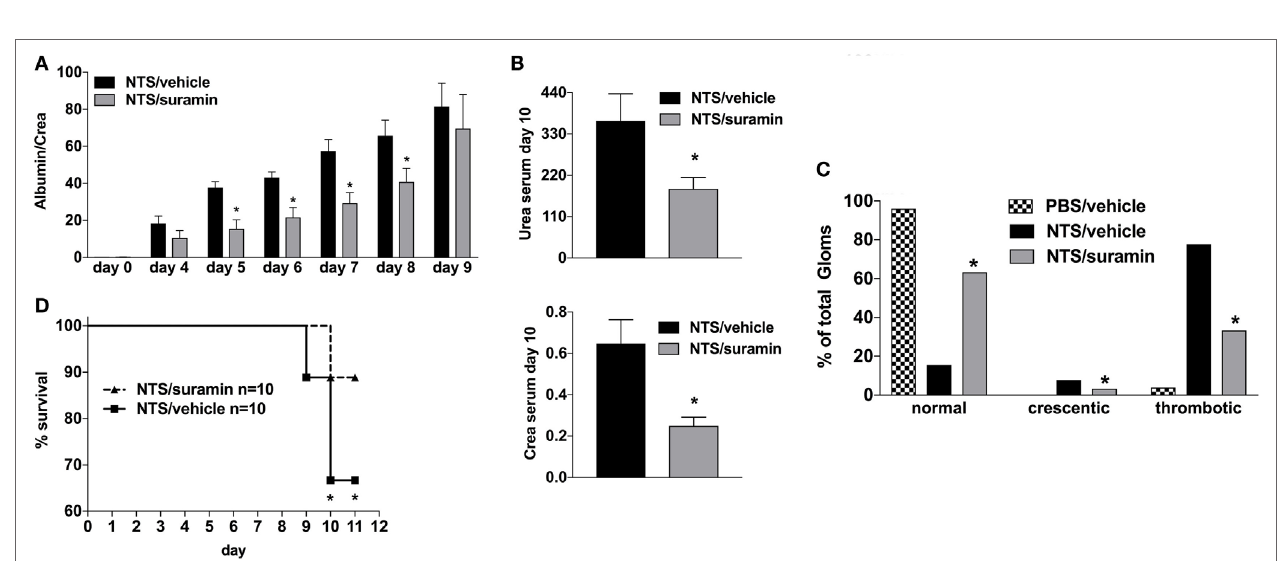
FigUre 3 | Effect of P2R-antagonist Suramin treatment on nephrotoxic serum (NTS)-driven glomerulonephritis (GN). C57BL/6 mice received either vehicle (PBS) or NTS (solved in PBS) intravenous on days 1, 2, and 3 to induce GN. For treatment, they received i.p. injections of either vehicle or suramin (100 µM in 100 µl) on days 1, 3, 5, 7, and 9. Urine was collected daily and analyzed for its albumin–creatinine quotient (a) . Animals were killed on day 10 after a blood sample had been taken. This was analyzed for its serum urea and creatinine levels (B) . From the killed animals, kidney tissue was prepared and analyzed with microscopy (PAS-staining). Approximately 100 Glomerula in each sample were analyzed following the histological criteria “normal, crescentic, or thrombotic” (c) . Follow-up of mice receiving apyrase or vehicle are shown (D) . Data are shown as mean ± SEM, n = 4–5 mice in each group. * P < 0.05 . Data from one representative experiment out of three are shown.